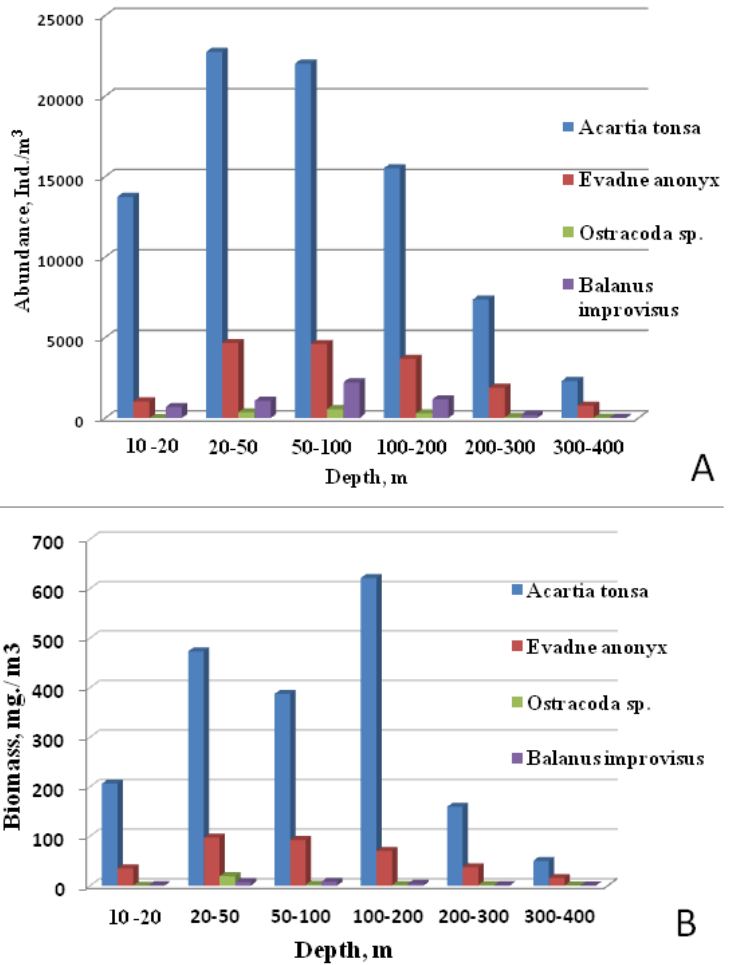
Figure 7. Change in the number ( A ) and biomass ( B ) of background zooplankton species with depth of the eastern section of the Middle Caspian, May 2016. The population of Evadne anonyx was of median density at depths of 10 to 300 m. The lowest population was found in the shallowest and deepest zones (less than 50 m and more than 300 m) with an average of 43 ind./m 3 . With depth changes, the most noticeable decrease was the population of the dominant species, Acartia tonsa . At 10–20 m, its abun- dance averaged 13,737 ind./m 3 , which increased to 22,014 ind./m 3 at 50–100 m. This num- ber decreased further to 2301 ind./m 3 at 300 m. As for other species included in the com- position of zooplankton, the minimum number of A. tonsa was found in the deepest zone (300–400 m) with an average of 2301 ind./m 3 . The average number of larvae of the barnacle crustaceans Cirripedia in areas 10–100 m deep did not change significantly, from 544 to 2273 ind./m 3 , and then changed sharply to decrease to 242 ind./m 3 at depths of 200–300 m and up to 52 ind./m 3 at depths of 300–400 m. The diversity of zooplankton, estimated by the Shannon–Weaver index, varied from 0.28 to 0.77 bps in the water area and from 0.26 to 0.76 bps (as density in mg). To a depth of 50 m, the values of the diversity index were close to average values, and then they increased sharply between 100–300 m and continued to increase slightly to reach maxi- mum values. With an almost unchanged composition and number of species, the spatial